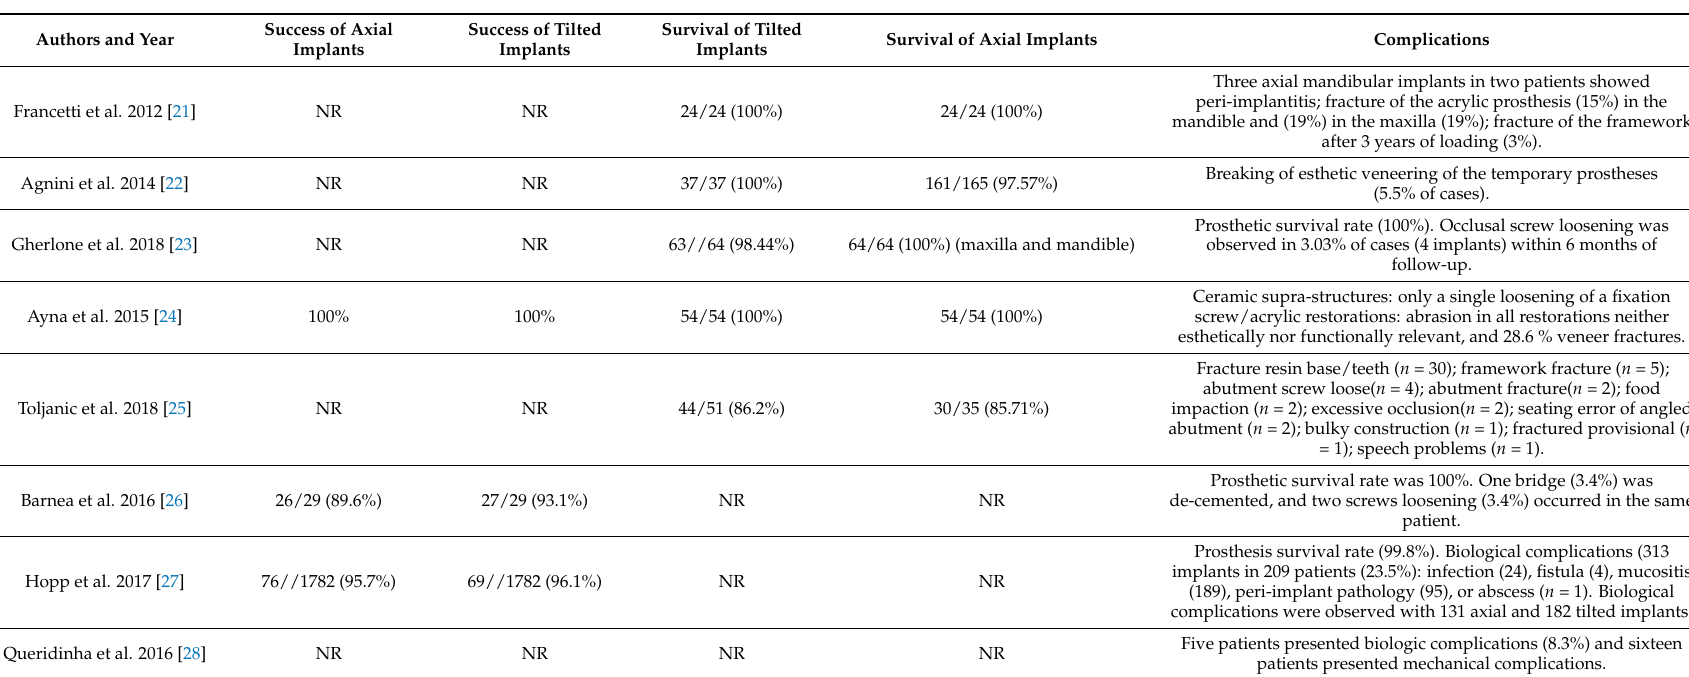
Table 3. Information about studies reviewed, evaluating straight implants compared with tilted implants supporting fixed restorations: study, implant survival rate, success rate, and